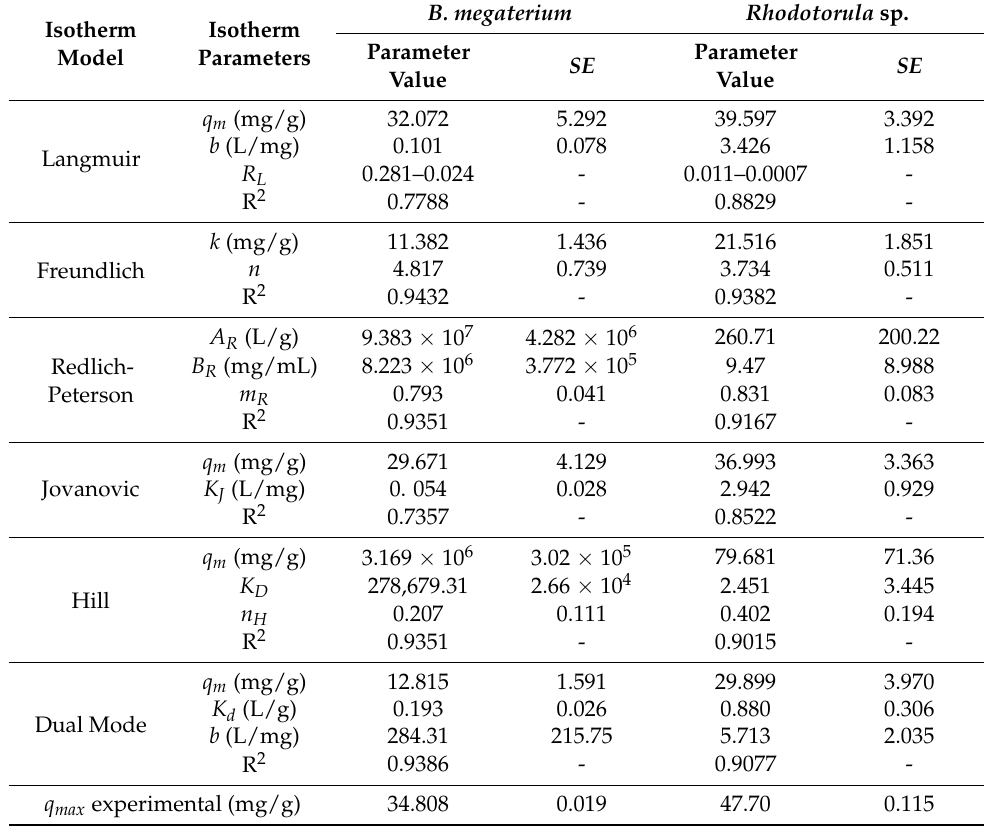
Table 4. Values of isotherm parameters applied to experimental data from the chromium ion